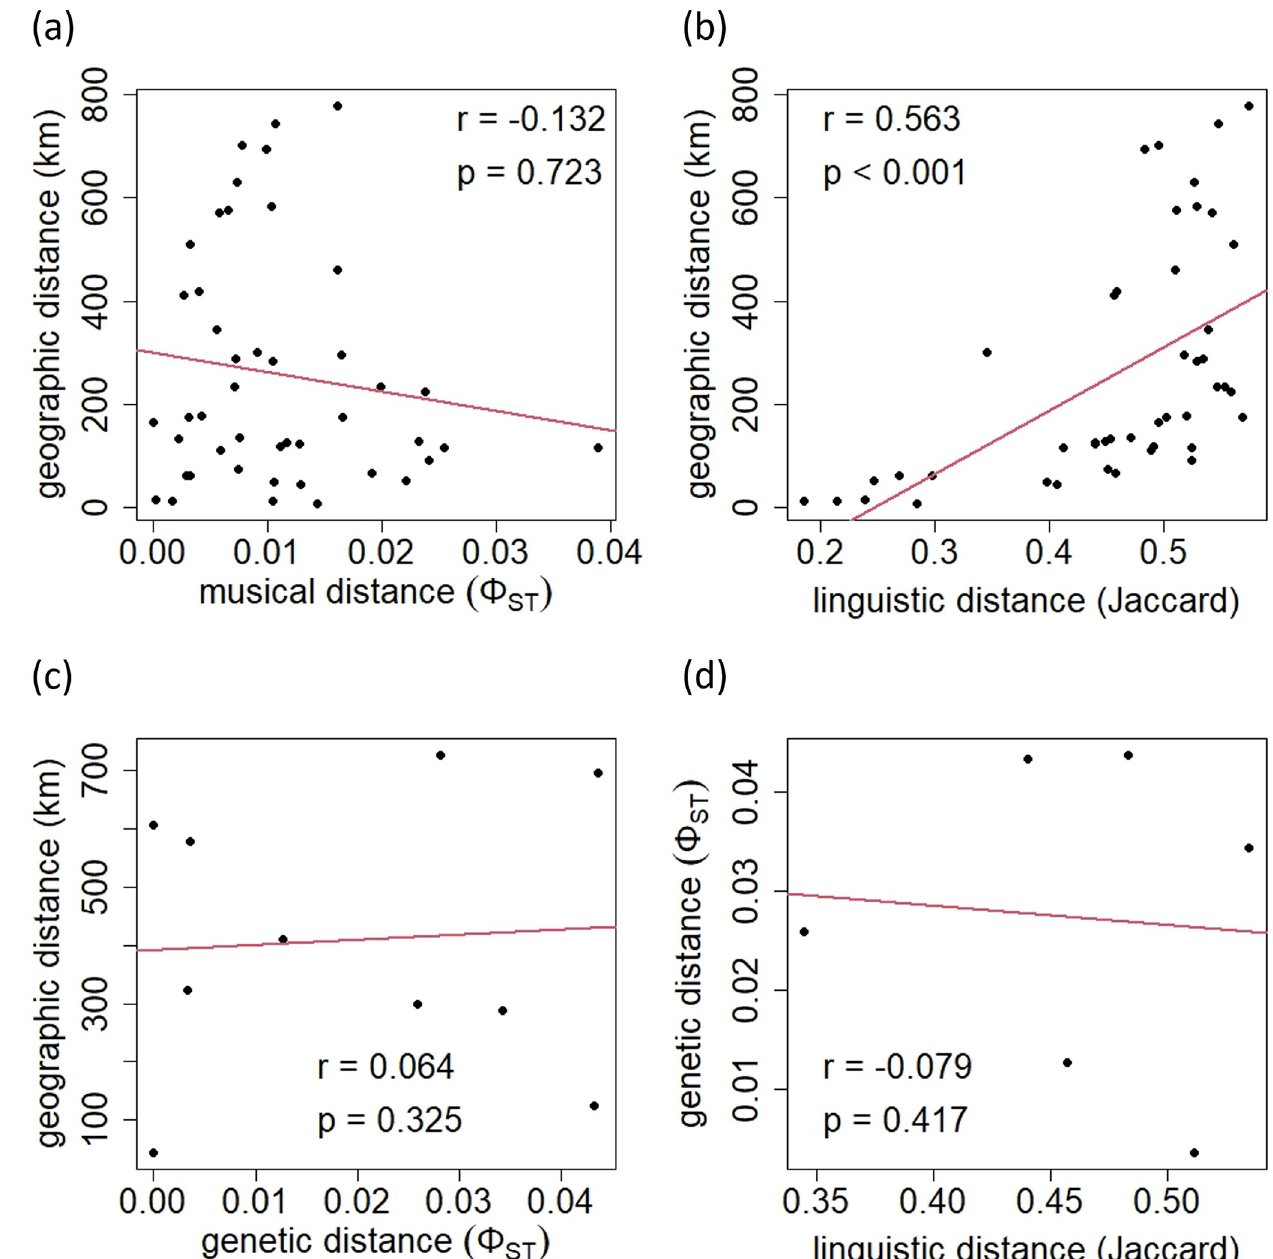
Fig 4. Regression plots. Regression plots for (a) music versus geography in the ten islands for which linguistic data were available, (b) languages versus geography in the ten islands, (c) genes versus geography in the five islands for which genetic data were available, and (d) languages versus genes in the four islands for which both linguistic and genetic data were available. There was significant correlation between languages and geography.